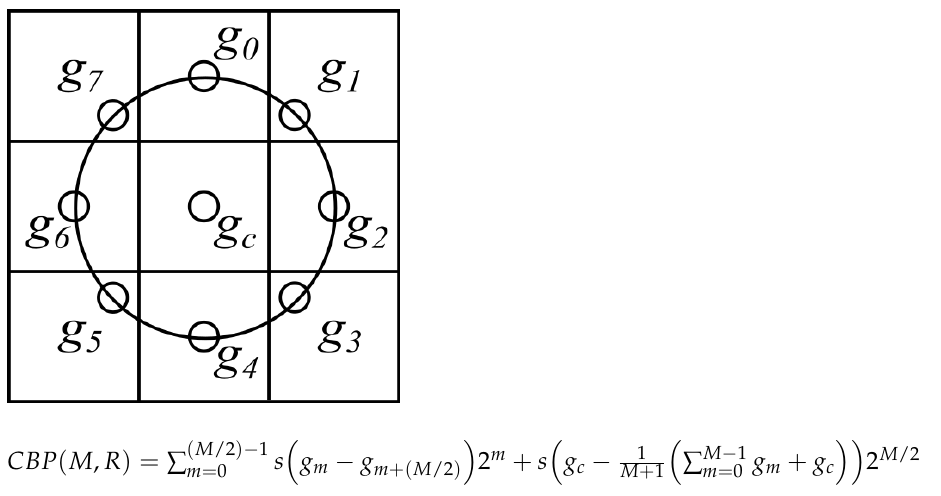
Figure 6. Detailed sampling for CBP operator with RX = RY = R = 1, PXY = M =